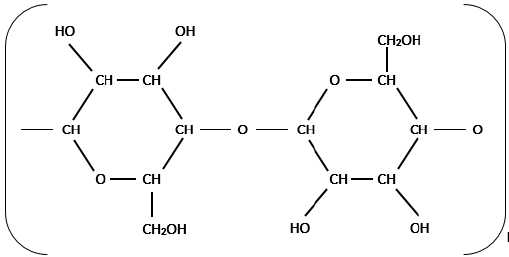
Figure 3. Molecular structure of cellulose.